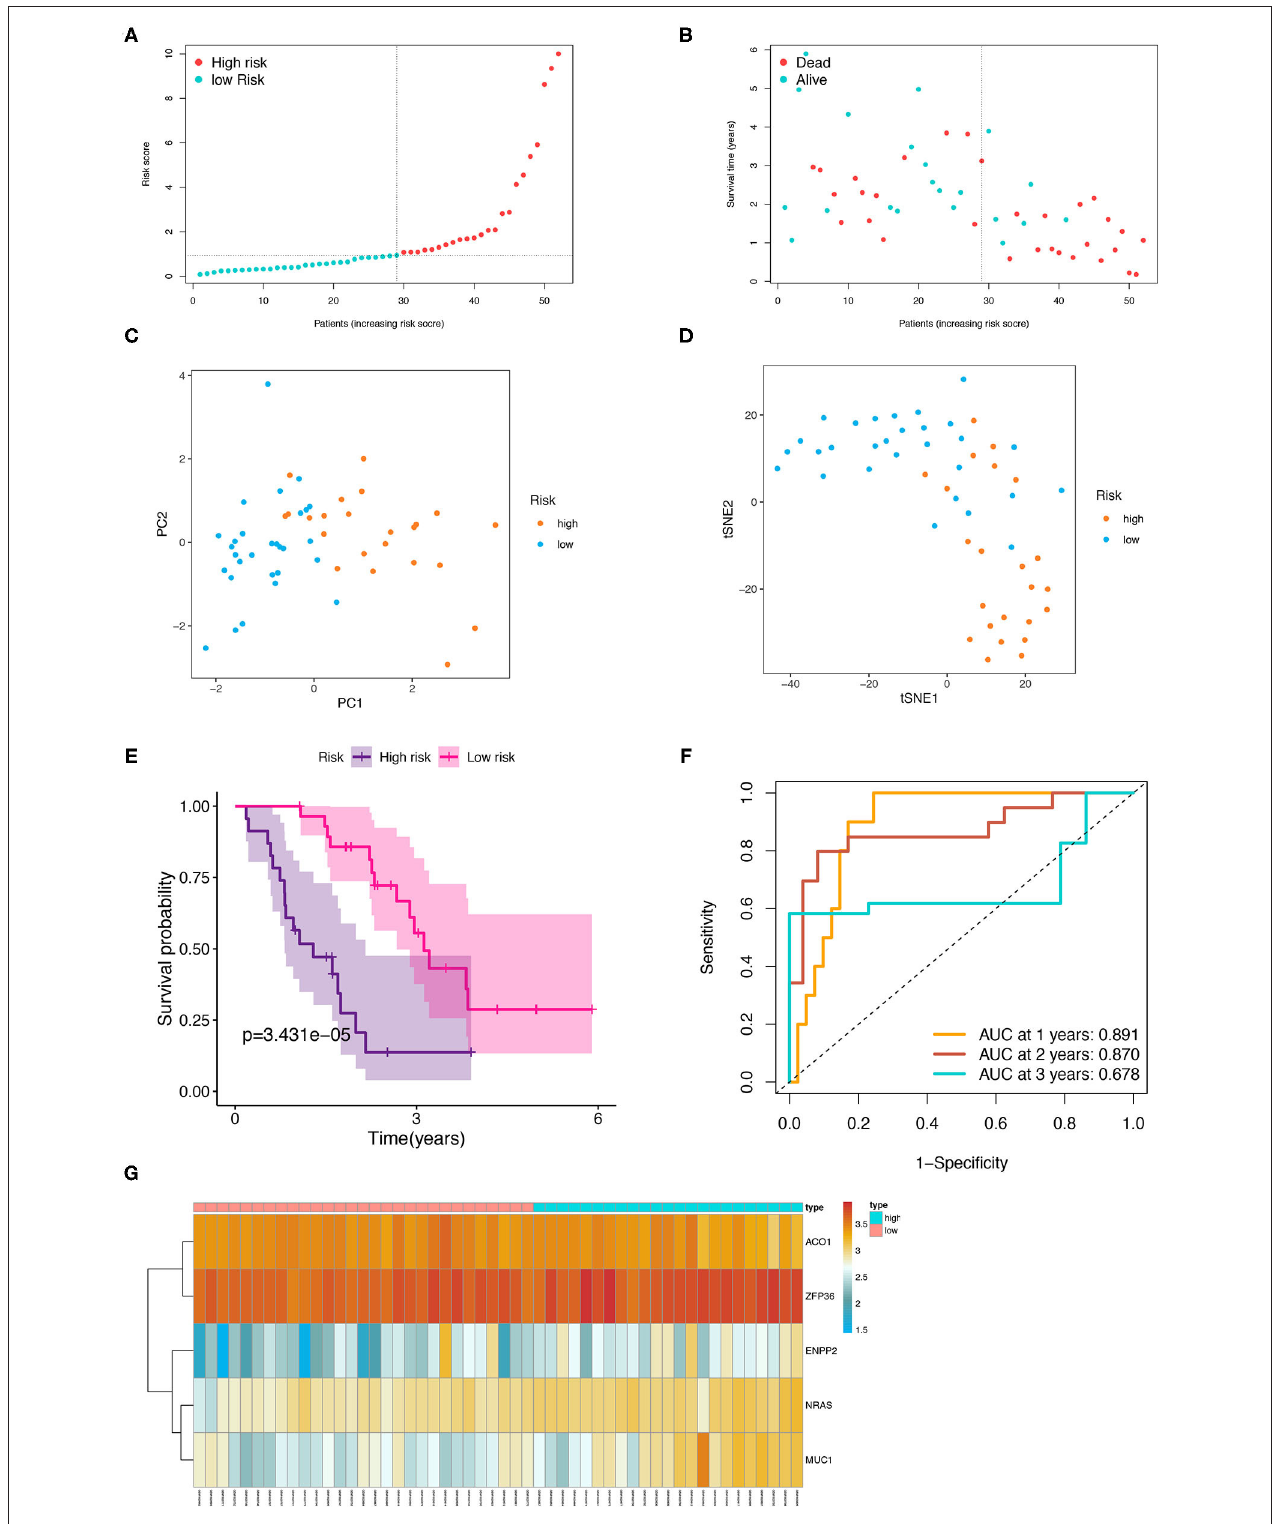
FIGURE 6 | Internal validation of the five-FRGs signature. Distribution of IPF samples (A) and OS status (B) based on the median value of the risk scores. PCA (C) and t-SNE (D) analysis of the testing group. Kaplan–Meier survival (E) and time-dependent ROC curve (F) analysis of the five-FRGs signature in the testing group. (G) Heatmap of the expression profiles of the five-FRGs in low- and high-risk groups of the testing cohort. FRGs, ferroptosis-related genes; IPF, idiopathic pulmonary fibrosis; OS, overall survival; PCA, principal component analysis; t-SNE, t-distributed stochastic neighbor embedding; ROC, receiver operating characteristic.